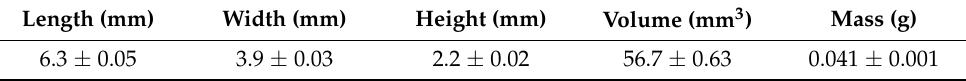
Table 1. Seed morphological characteristics (mm) and seed mass (mg) for the invasive tree